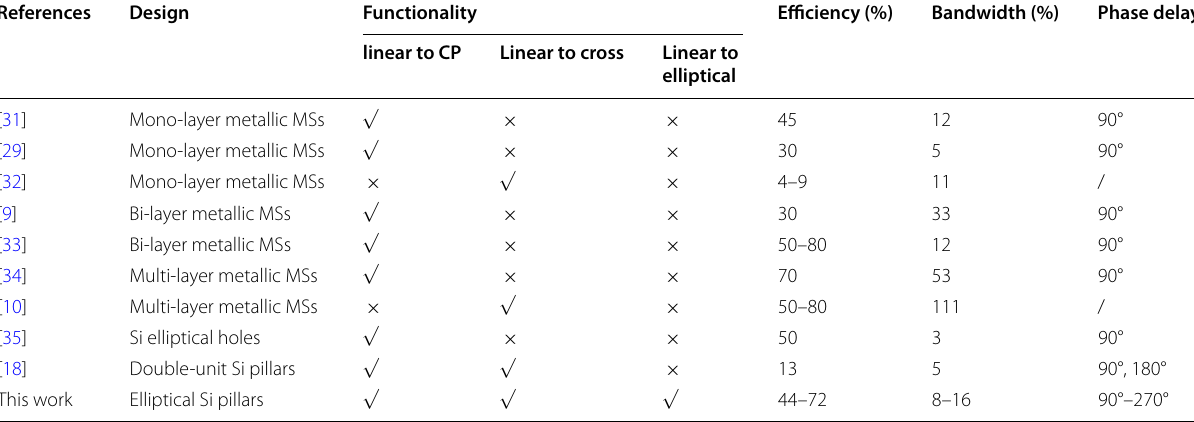
Table 1 Comparison of the proposed design with other terahertz polarization converters